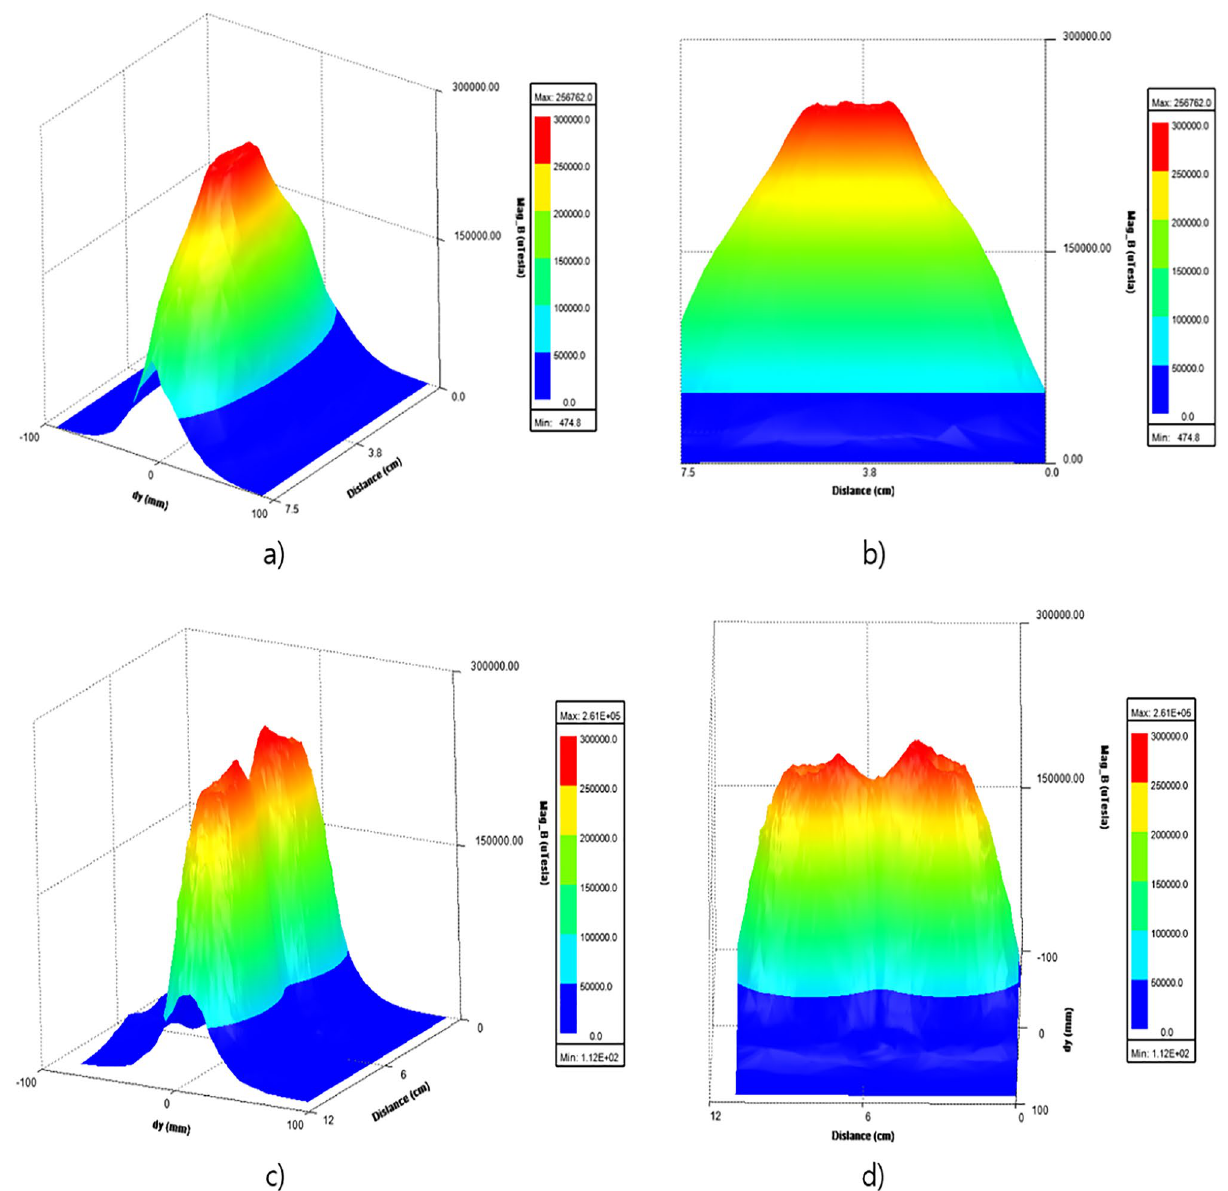
Figure 6. 3D plot of magnetic field intensity of ( a and b ) Circular coil, ( c and d ) Figure 8-shaped coil with respect to